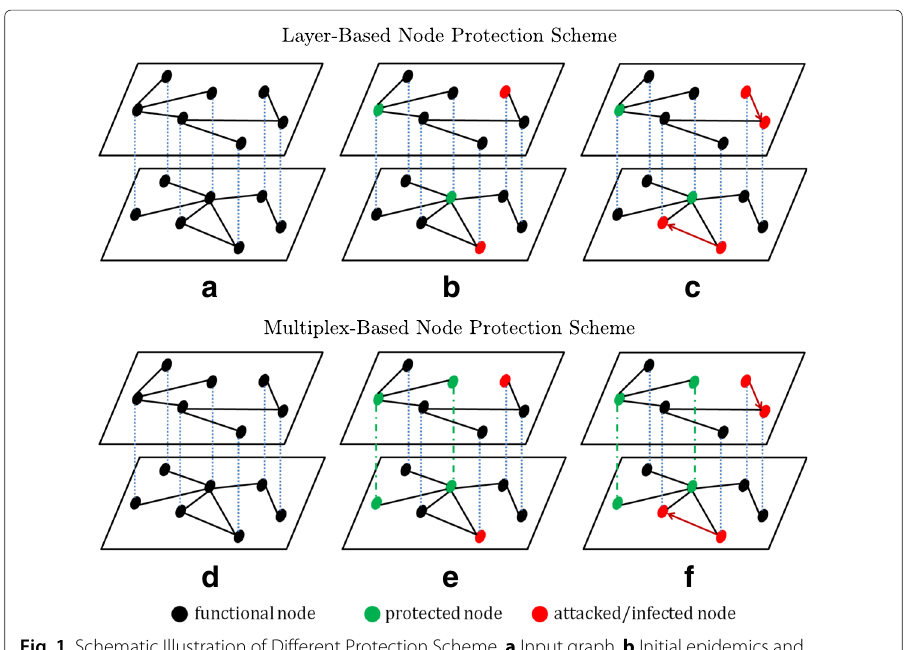
Fig. 1 Schematic Illustration of Different Protection Scheme. a Input graph. b Initial epidemics and protection condition at timestamp t = 0. c Infected nodes start to infect their neighbors at timestamp t = 1. d Input graph. e Initial epidemics and protection condition at timestamp t = 0. f Infected nodes start to infect their neighbors at timestamp t =